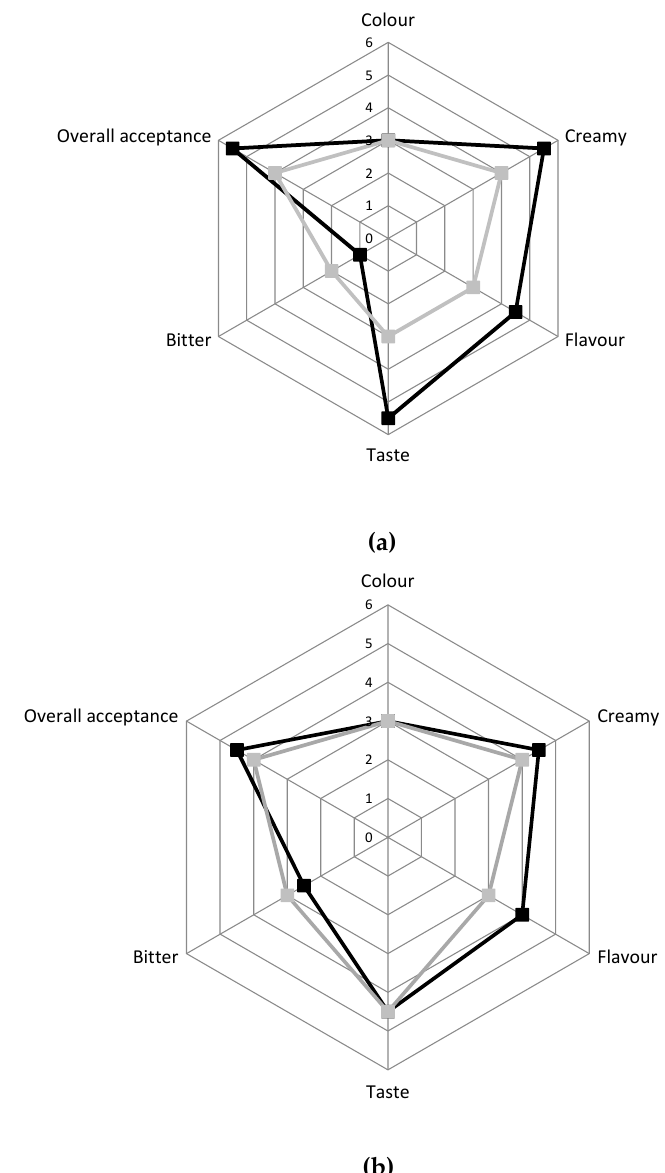
Figure 4. Sensory evaluation of C and INN Squacquerone cheeses performed after 6 days ( a ) and 15 days ( b ) of refrigerated storage.